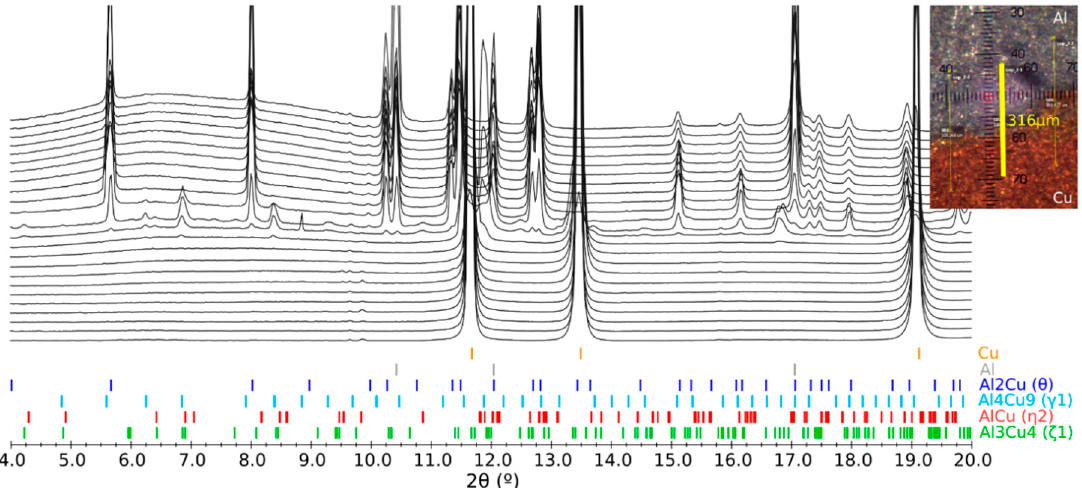
Figure 4. Plotting of the diffraction patterns along a laser welded Al-Cu joint (along the yellow line in the inset) with the assignment of the intermetallic phases formed during the process